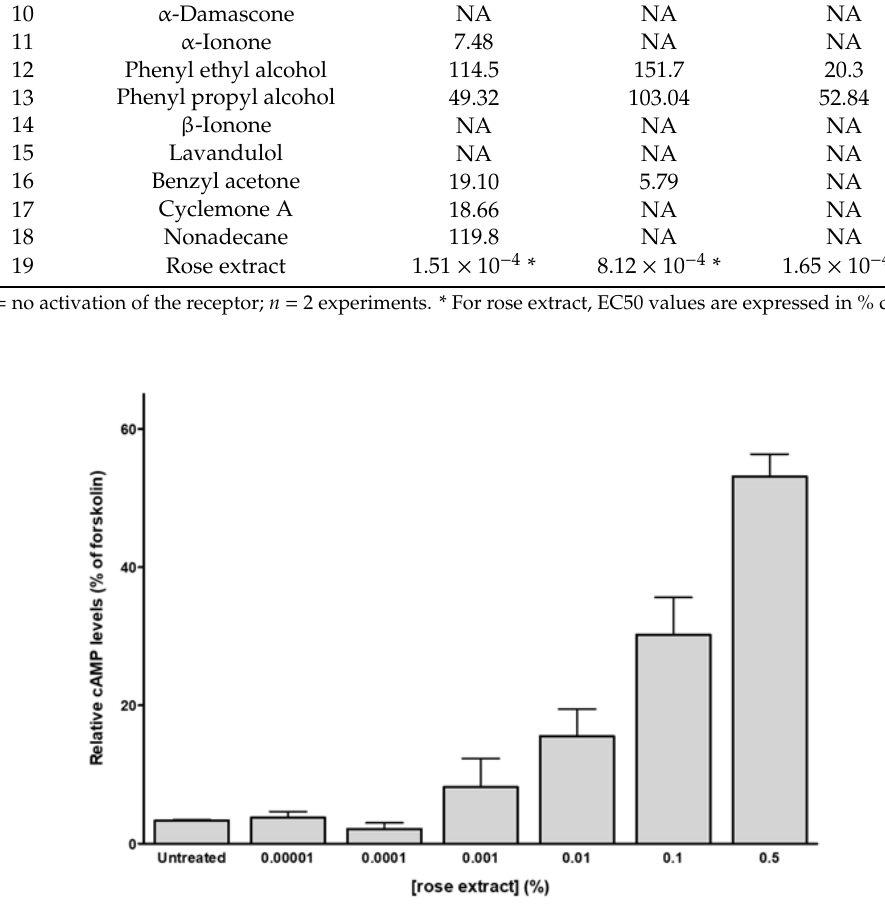
Figure 2. Rose extract dose-dependently increases intracellular cAMP in NHEK cells after 30 min of stimulation. Data are expressed as mean ± SEM values of percent cAMP activity over forskolin (positive control, 10 µ M, ( n = 3)).